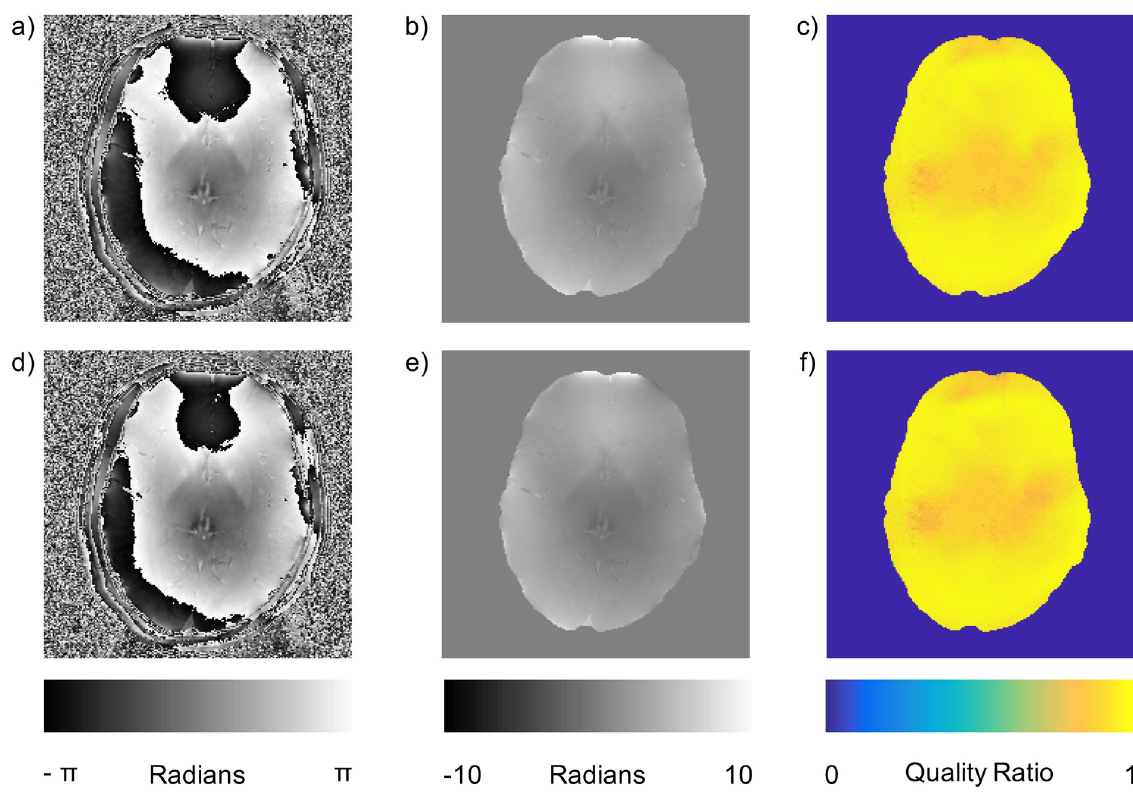
Fig 6. Effects of motion on the fitted SVD method. a) Raw phase image, b) unwrapped phase image, c) quality ratio map created with no motion between the B þ prescan and the imaging. d) Raw phase image, e) unwrapped phase image, f) quality ratio map created with 3.5 mm 1 prescan and the imaging. No singularities were motion between the B þ 1